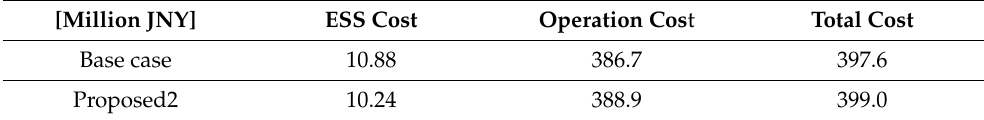
Table 6. Battery placement